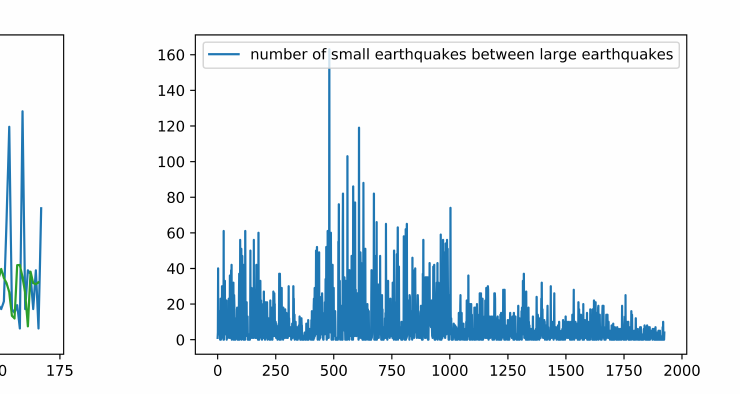
Figure 4. Time series of number of small earthquakes between two subsequent earthquakes and corresponding training and validation predictions in Experiment 3